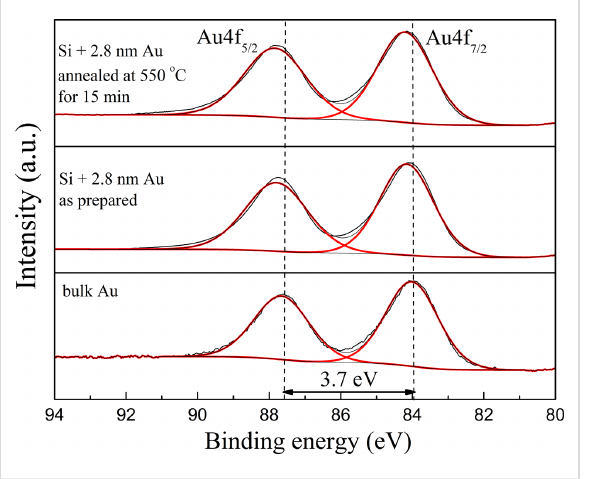
Figure 8: XPS (Au region) results for the 2.8 nm Au thin film on a Si(111) substrate annealed at 550 °C for 15 min, the as-prepared 2.8 nm Au film on Si(111) and bulk Au.